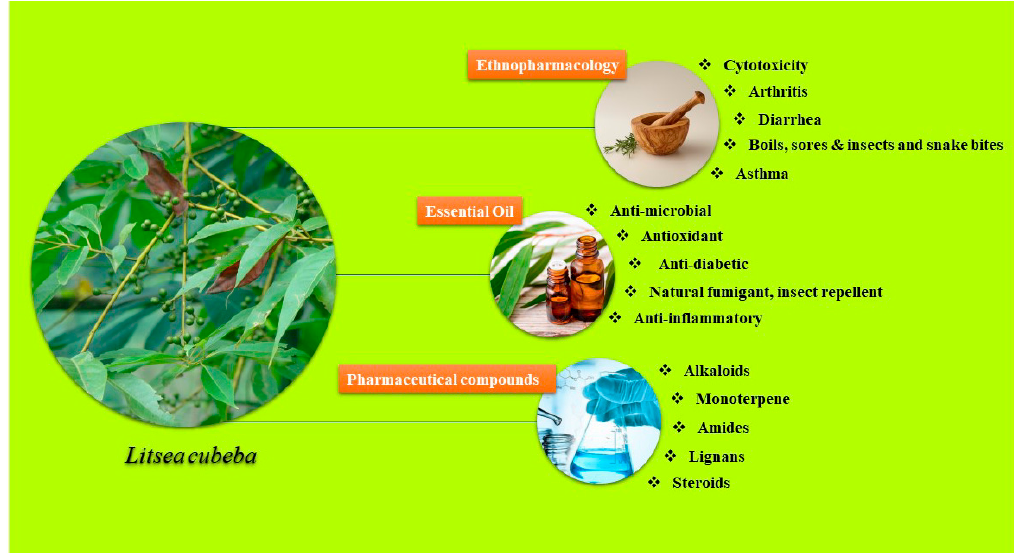
Figure 1. Various ethnopharmacological applications and uses of essential oil of Litsea cubeba.